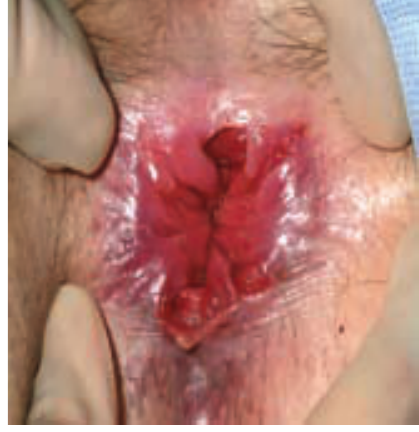
Figure 1 Perianal examination with